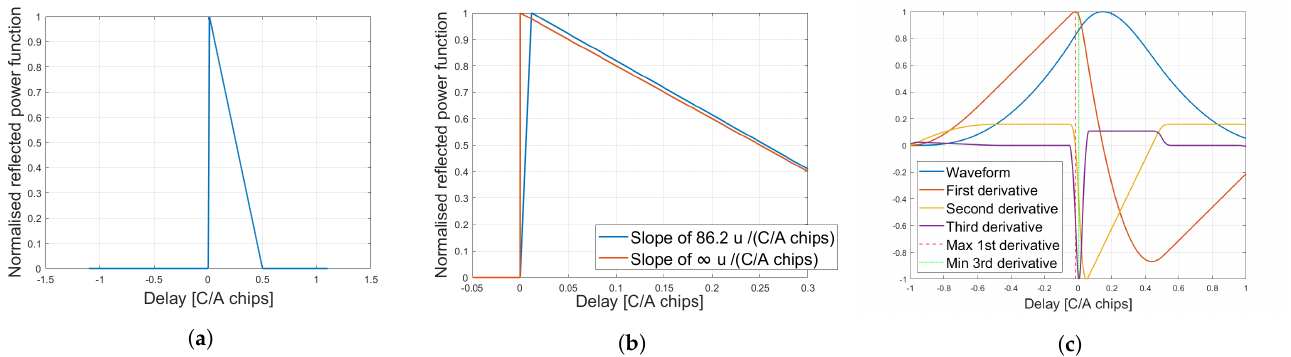
Figure 9. ( a ) Simulated reflected power function as a function of the delay with a leading edge slope of 86.2 u/(C/A chips) (SWH ≈ 1.7 m). ( b ) Comparison between the reflected power function with a leading edge slope of 86.2 u/(C/A chips) compared to the one from Case 1 (Figure 6b) with infinite slope. ( c ) Simulated low-pass filtered version of a reflected waveform for a rough sea (SWH ≈ 1.7 m, bandwidth ≈ 5.115 MHz).